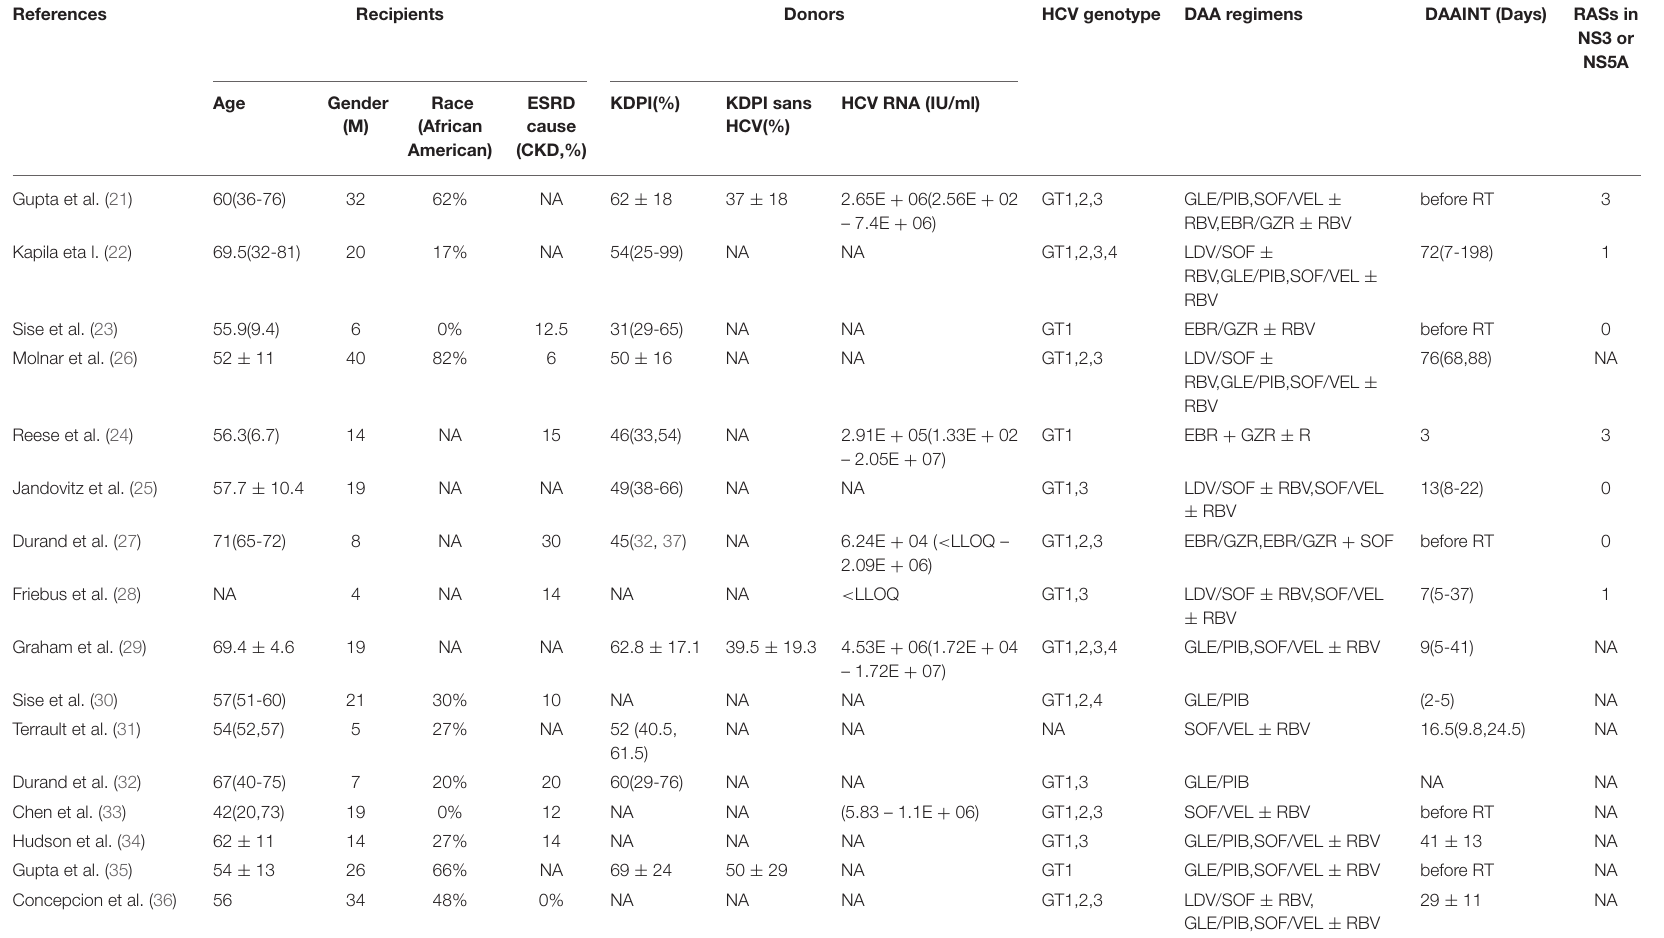
TABLE 2 | Patient characteristics of the studies enrolled in this comprehensive